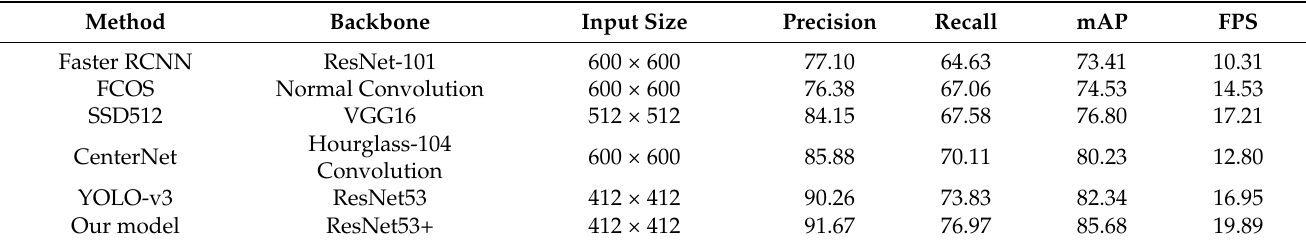
Table 3. The experimental results of all models.